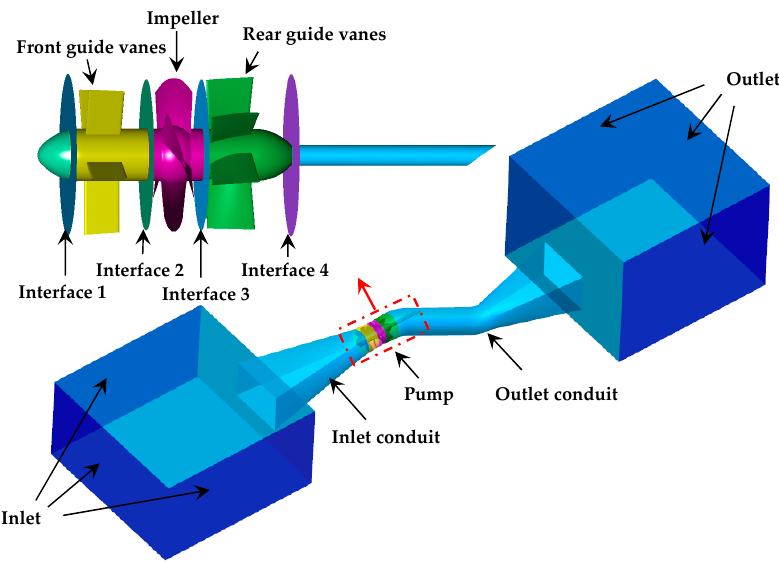
Figure 2. Geometric model of the whole flow system for the axial-flow pump. Table 1. Characteristic parameters of the pump flow system.